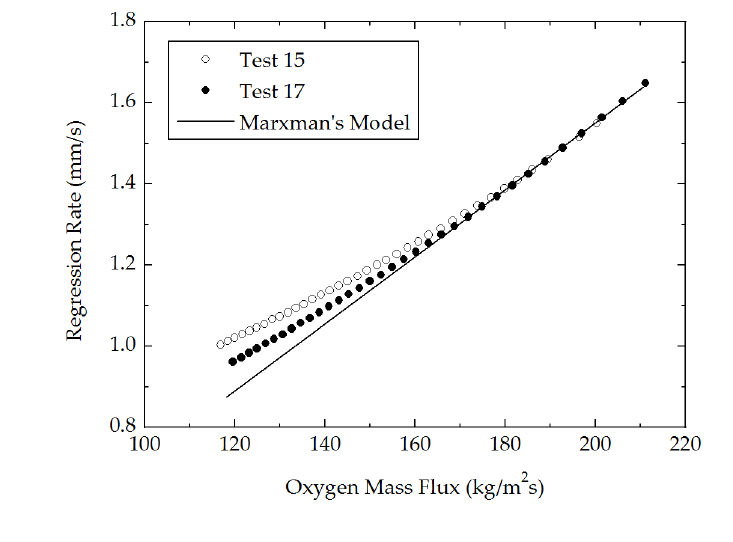
Figure 4. Effect of thermal radiation on hydroxyl-terminated polybutadiene (HTPB) regression-rate behavior. Data taken from